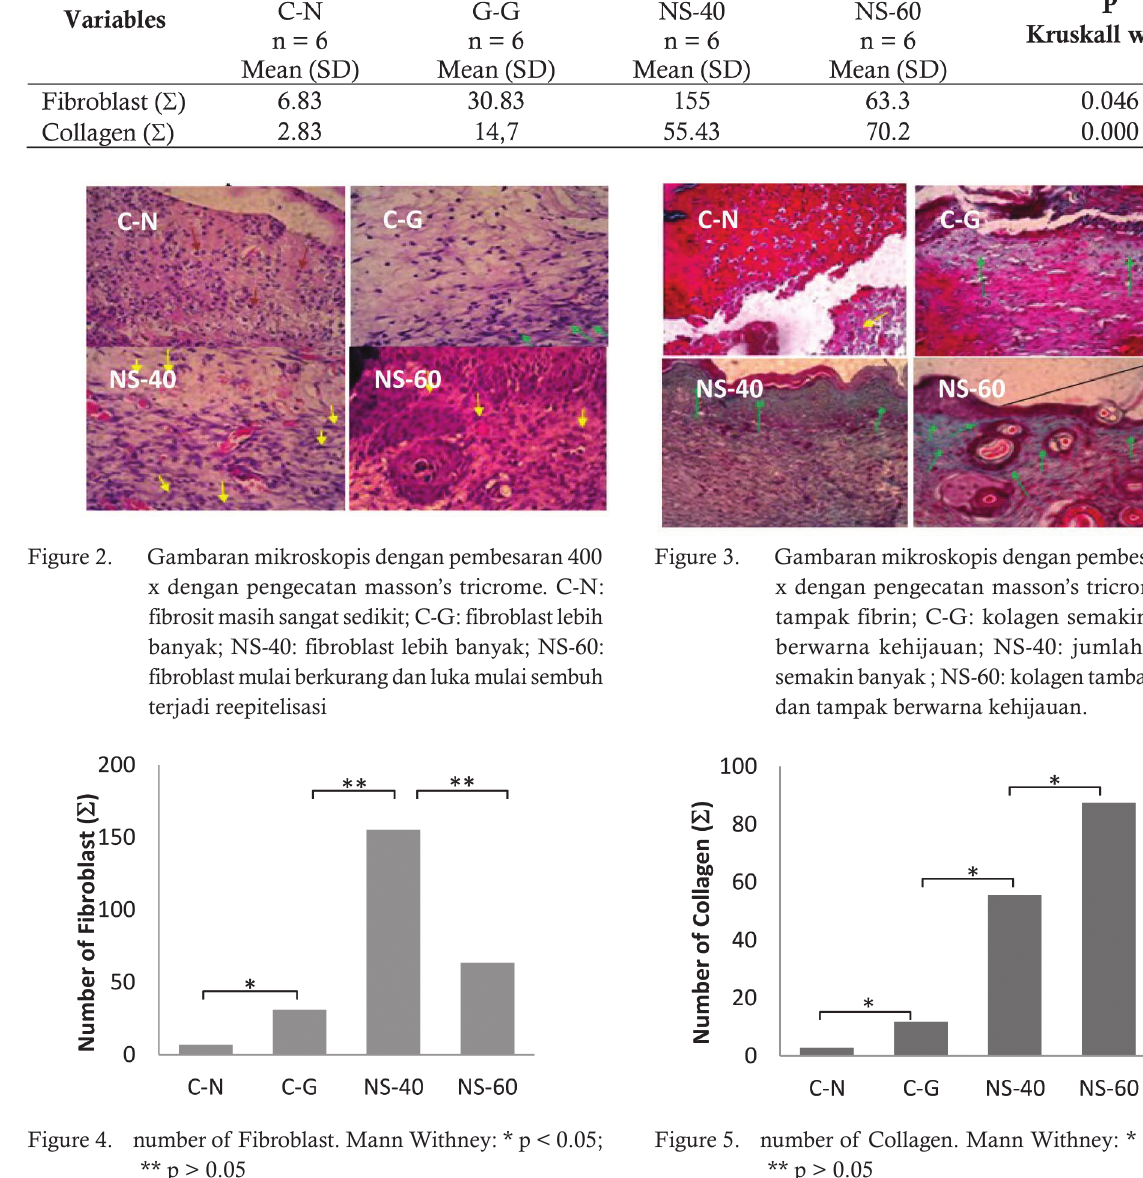
Figure 5. number of Collagen. Mann Withney: * p < 0.05; ** p >